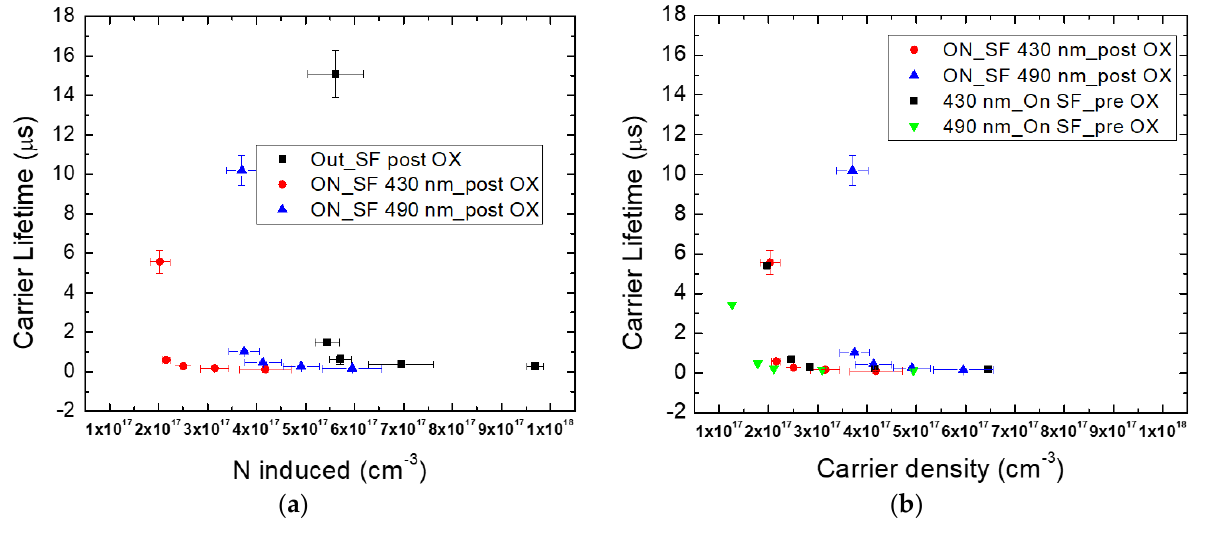
Figure 8. Carrier lifetime as a function of carrier induced. Comparison between SF-free area and defective zone ( a ); comparison between the same defects (430–490 nm) before and after oxidation process ( b ).